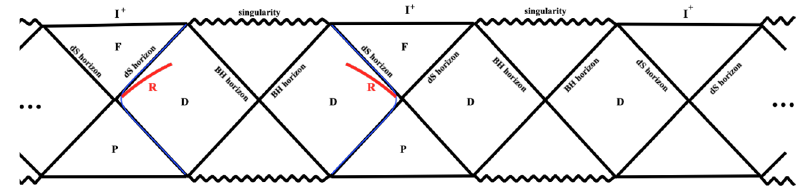
Figure 1 . The Schwarzschild de Sitter black hole Penrose diagram, with focus on one black hole “patch”.